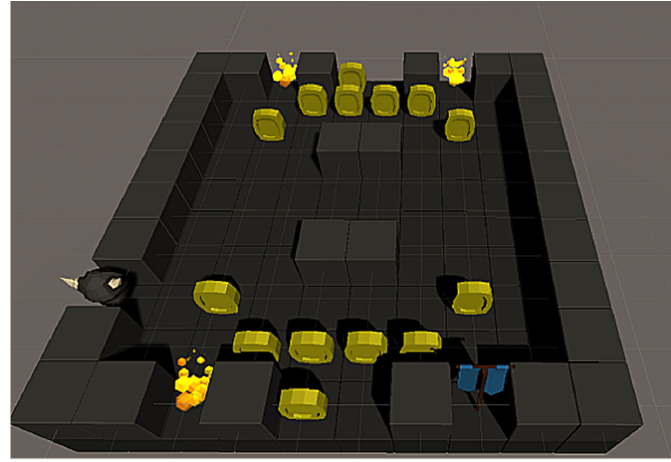
Figure 9. Room-like generated scene.